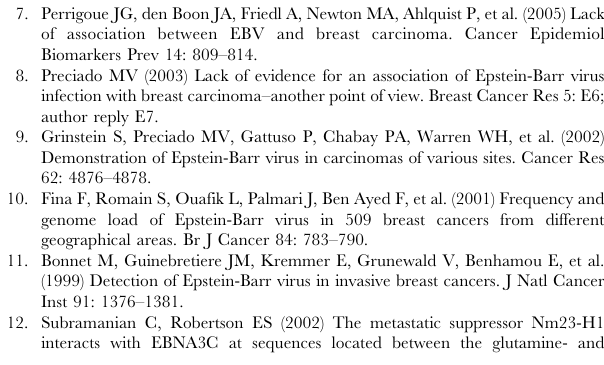
Figure S1 Flow of involved studies. Table S1 Detail information and list of extracted studies for general analyses. Table S2 Detail information and list of extracted studies for meta-analysis. Table S3 Primary results of individual studies adopted in the meta-analysis. Table S4 Sensitivity analysis after each study was excluded by